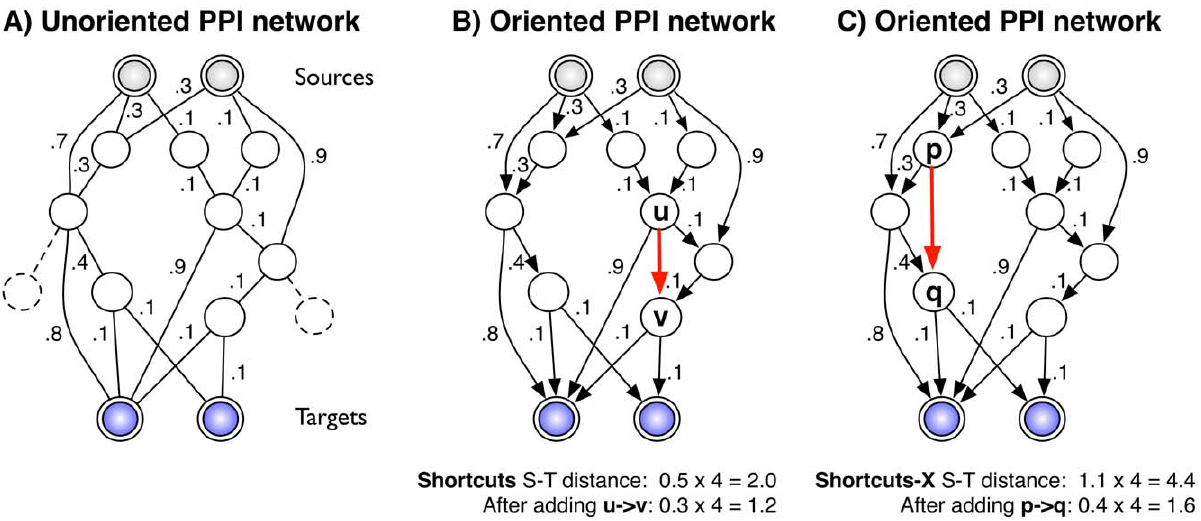
Figure 1. Overview of our approach. A) Example input network with sources, targets, and undirected edges. Each edge is given a weight (lower values indicate higher confidence). The total distance from each source to each target is 2.0. B) The corresponding oriented network. Nodes and edges that do not lie within a path of r ƒ 3 hops from any source-target pair are purged (shown dashed in A). The red arrow indicates an edge prediction ( u ? v ) that globally minimizes the distance between each source and target using the S HORTCUTS objective function. The new distance is 1.2. C) The corresponding example using the S HORTCUTS -X objective function with r ƒ 3 . Here, the total hop-restricted distance between each source and target is higher (4.4) and the optimal edge, p ? q reduces the distance to